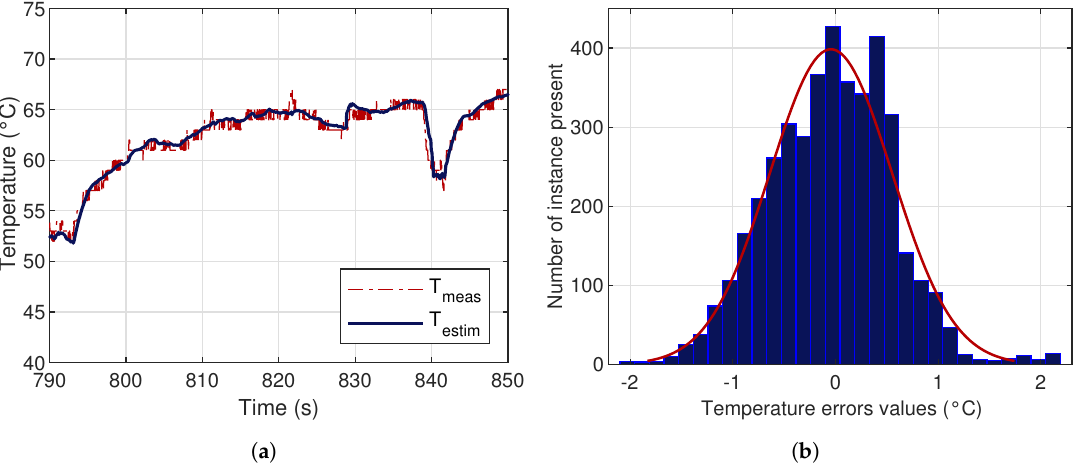
Figure 10. The Autoregressive–Moving-Average with Exogenous Inputs (ARMAX) temperature model perfomance. ( a ) ARMAX model temperature estimations compared to system readings. ( b ) Distribution of the ARMAX Temperature estimation